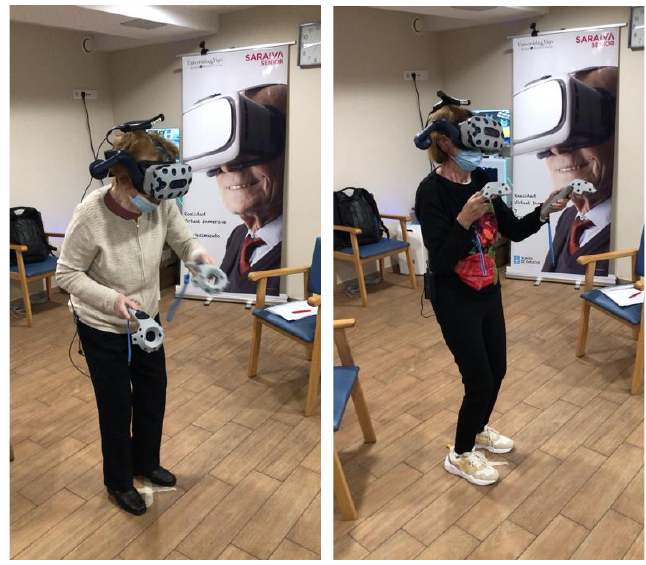
Figure 4. Participants during an exergaming session guided and supervised by a physiotherapist.